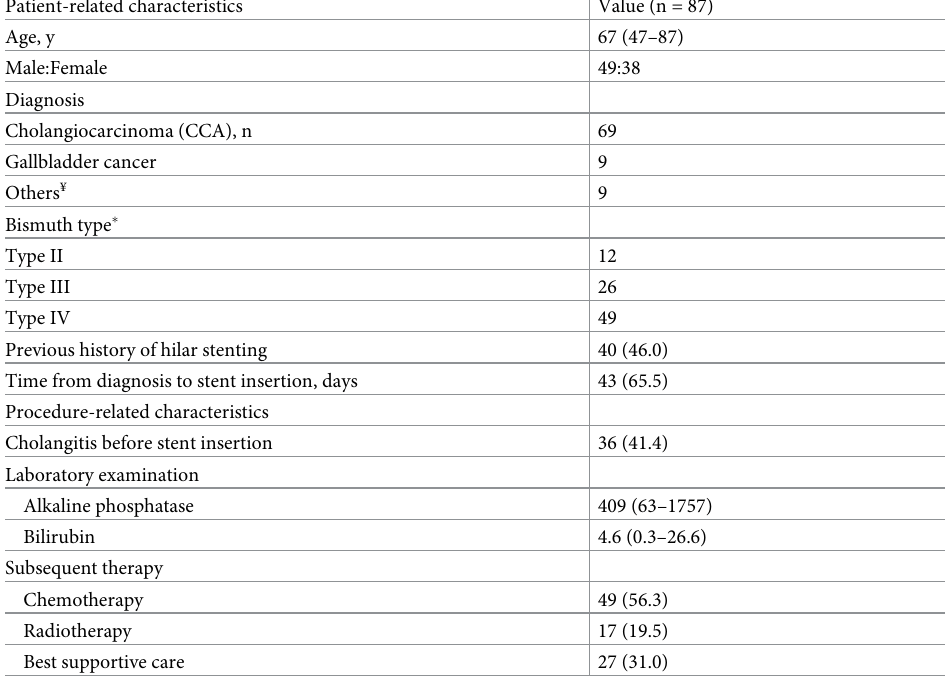
Table 1. Baseline characteristics of